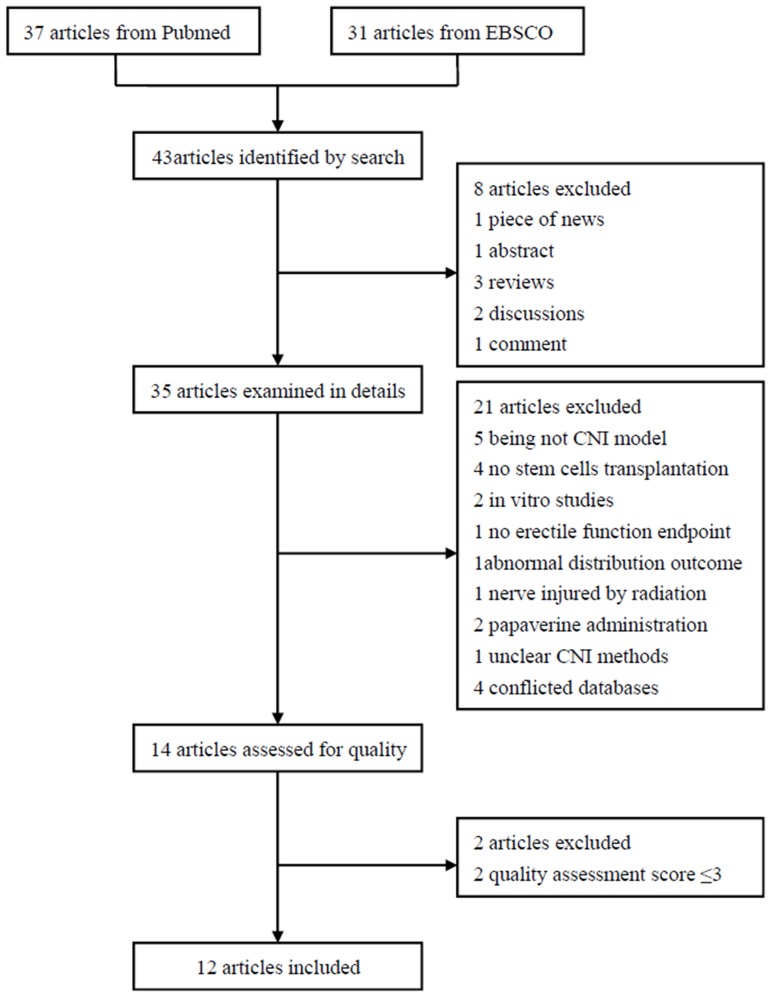
Flowchart of enrolled studies on stem cell therapy in ED rats with CNI.